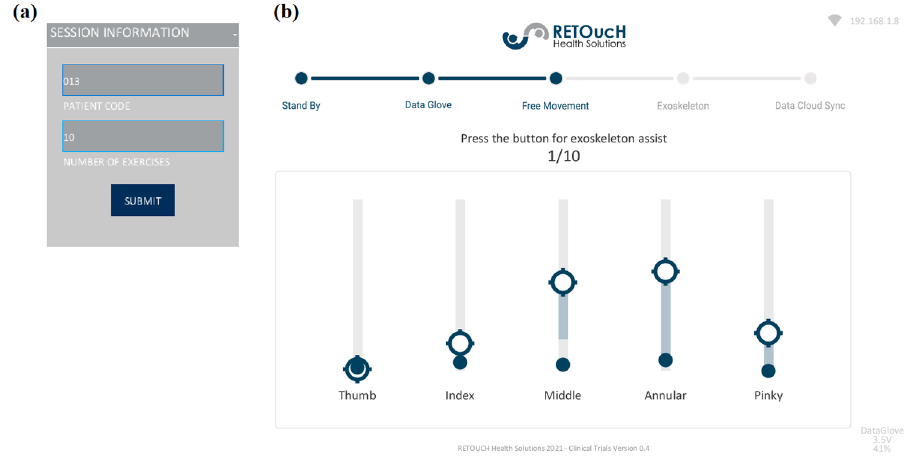
Figure 7. ( a ) Initial window with session information; ( b ) Main window of GUI application.